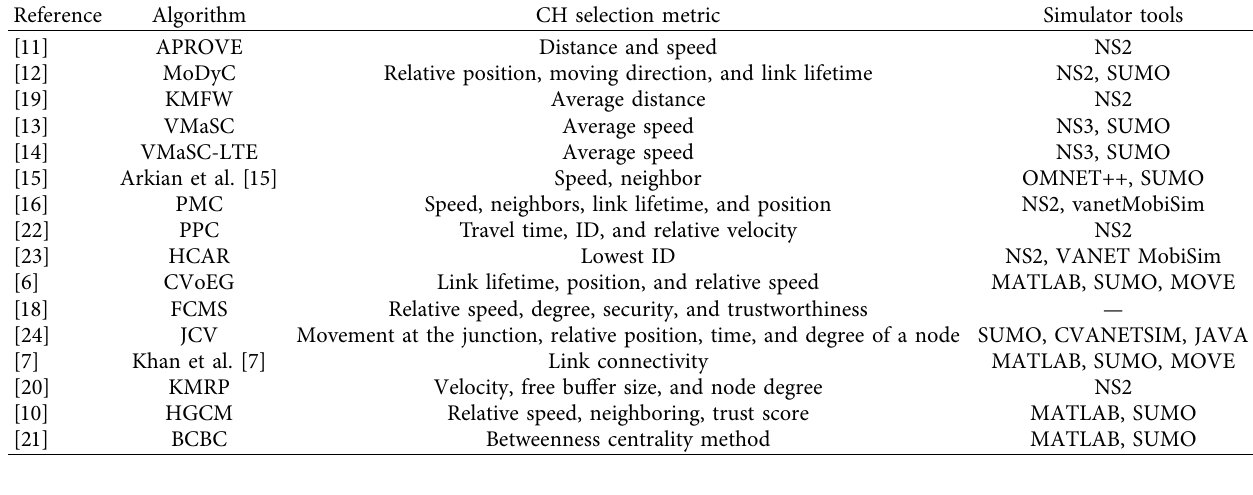
Table 1: State-of-the-art